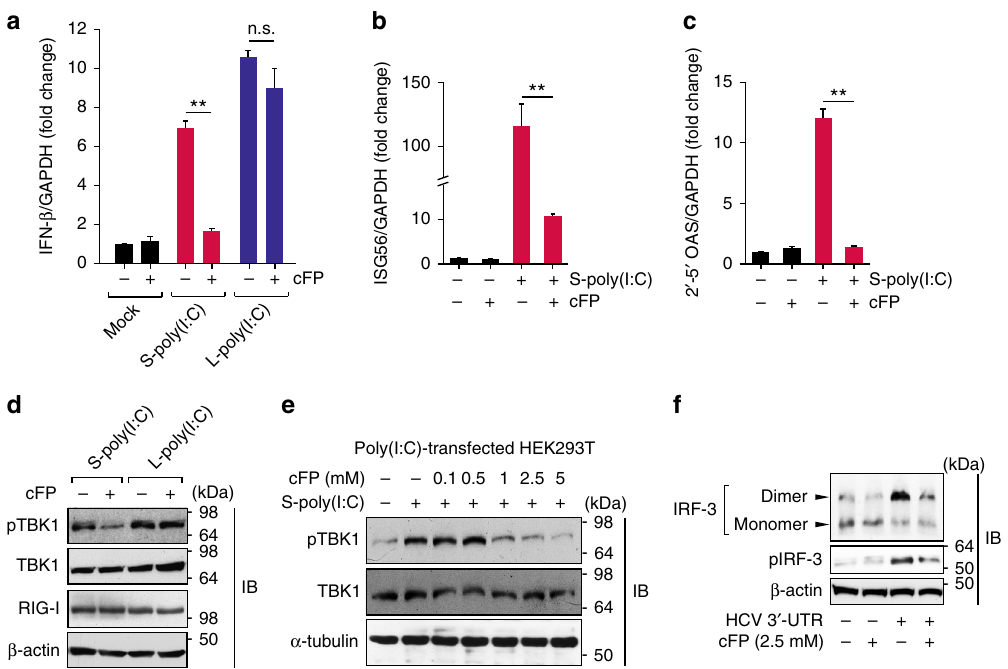
Fig. 2 cFP inhibits RIG-I-mediated innate immune responses. a – d HEK293T cells, which were stimulated with 2 μ g ml − 1 of indicated poly(I:C), were left untreated or treated with 2.5 mM cFP for 12 h, prior to quanti fi cation of IFN- β ( a ), ISG56 ( b ), and 2 ′ -5 ′ OAS ( c ) mRNA levels or immunoblotting analysis for the indicated proteins ( d ). In a – c , data are mean ± s.d. ** P ≤ 0.01; n.s., not signi fi cant; by unpaired two-tailed Student ’ s t -test. e Inhibition of TBK1 activation by cFP. Activated TBK1 (pTBK1) levels in HEK293T cells transfected with 1 μ g ml − 1 of S-poly(I:C) were monitored by immunoblotting 6 h after cFP treatment. f Analysis of IRF-3 and its activated form (pIRF-3) expression in HCV 3 ′ -UTR RNA-transfected HEK293T cells, which were left untreated or treated with 2.5 mM cFP. Cell lysates were subjected to native PAGE or SDS-PAGE for immunoblotting analysis for IRF3 dimers and pIRF-3, respectively at 12 h post-transfection with HCV 3 ′